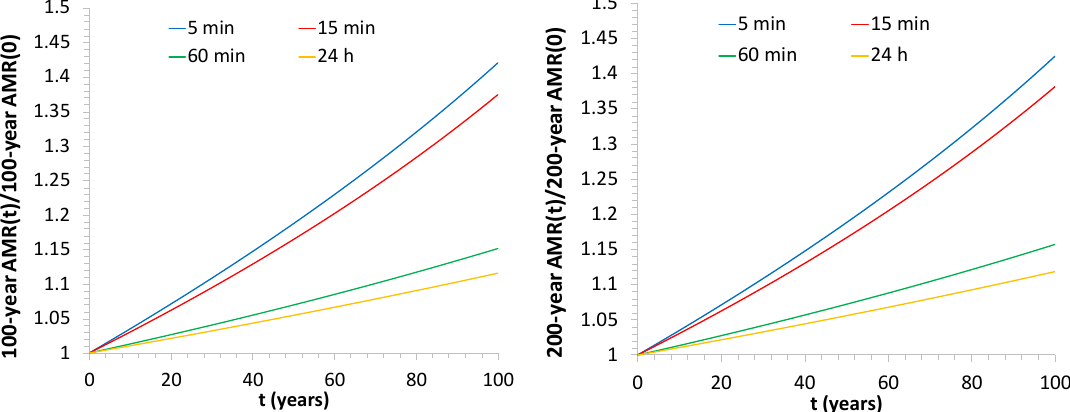
Figure 10. Temporal variation of 100-year ( left ) and 200-year ( right ) AMR quantiles with respect to the correspondent values R ∗ of the stationary